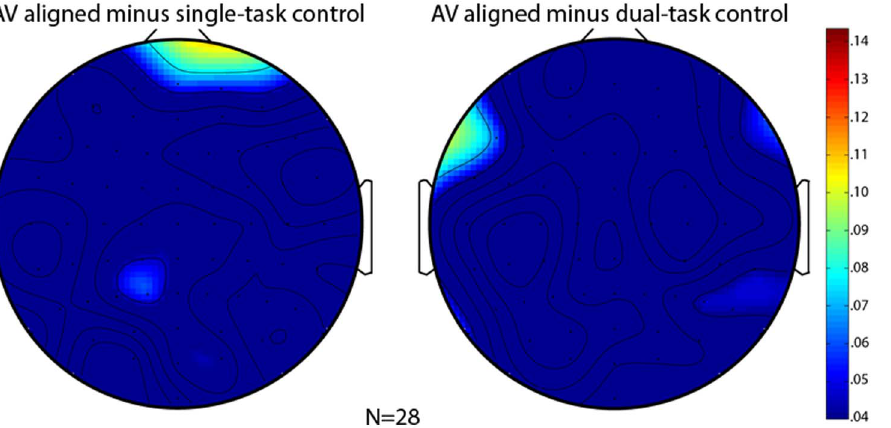
Figure 2. Scalp topography of the ASSR amplitude difference between the AV-aligned and single-task control conditions (left), and between the AV-aligned and dual-task control conditions (right). Bar to the right indicates scale.